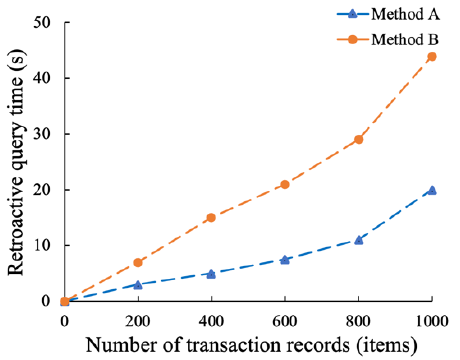
Figure 9. Time-consuming comparison of traceability for methods A and B.